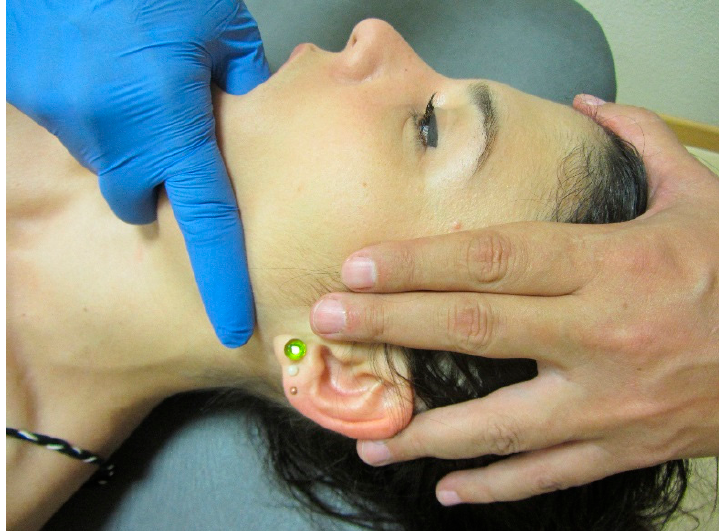
Figure 3. Mandibular distraction mobilisation technique. Copyright Handspring Publishing Limited 2018. Reproduced with permission. Illustrations first published in Temporomandibular Disorders edited by César Fernández ‐ de ‐ las ‐ Peñas and Juan Mesa ‐ Jiménez, Handspring Publishing Limited, 2018.